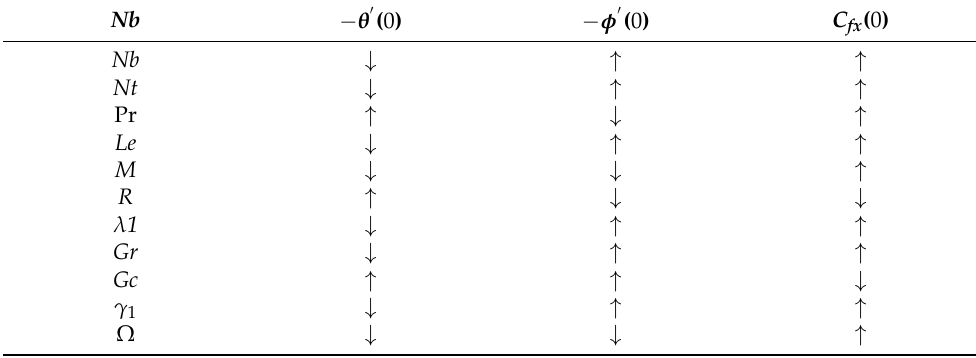
Table 3. Summary of results for − θ (cid:48) ( 0 ) , − φ (cid:48) ( 0 ) , and C fx ( 0 ) .